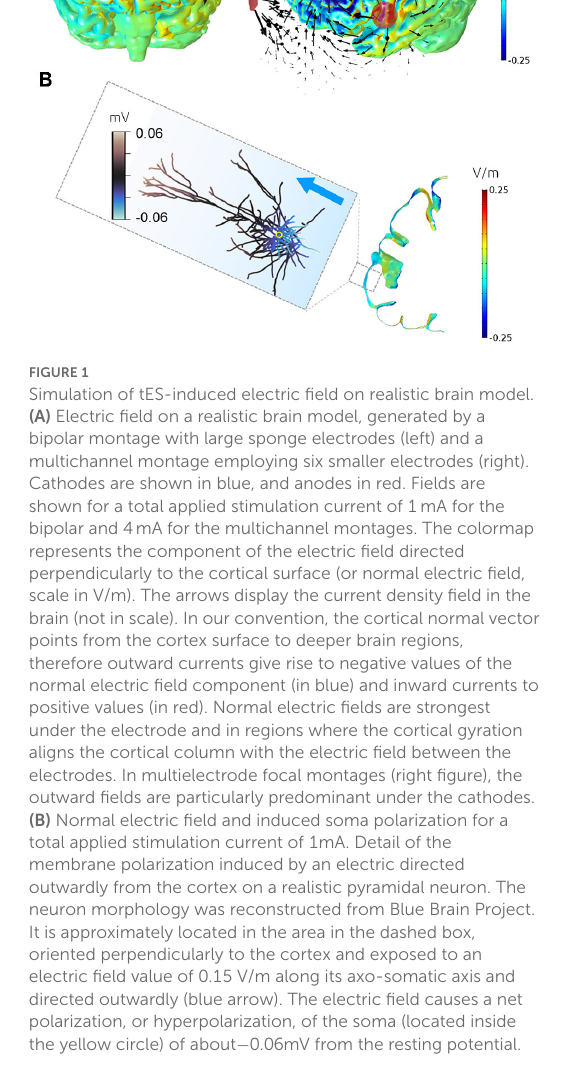
and its effects on the underlying basic